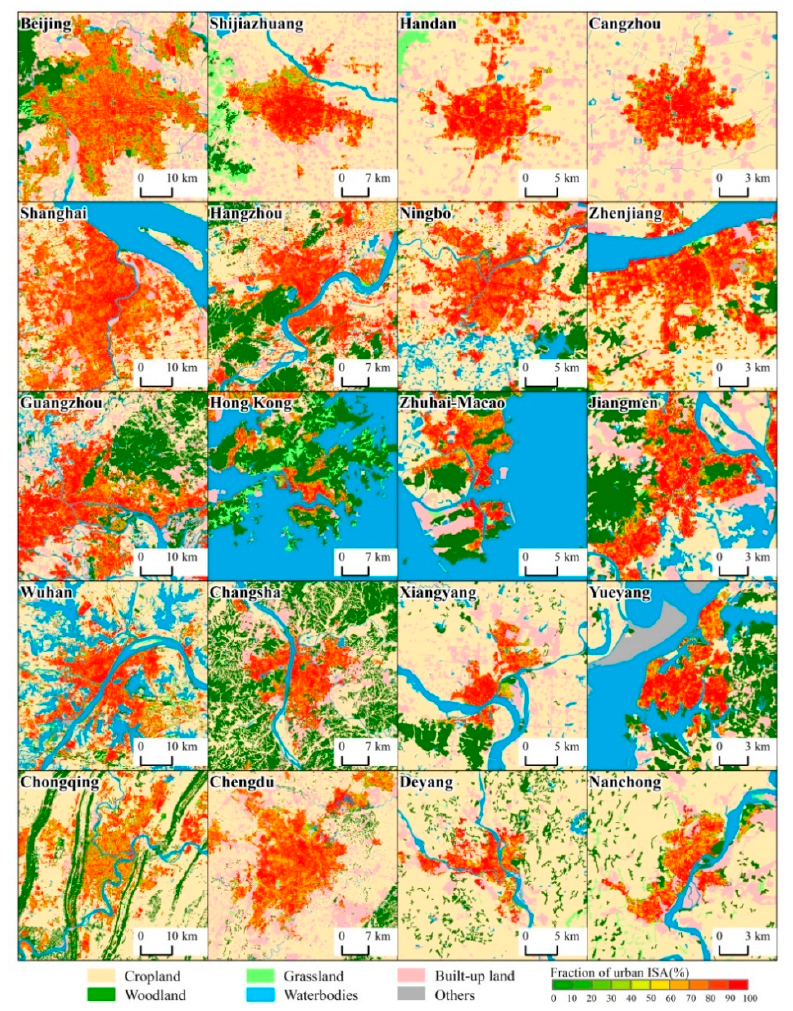
Figure 4. The urban impervious density from CLUD-Urban for cities in 2015. Table 3. Proportion of land use / cover type among megaregions in